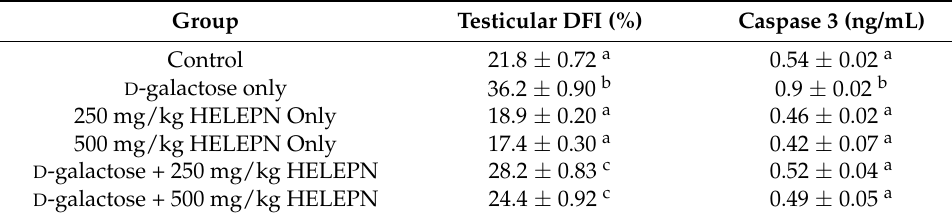
Table 4. Effect of graded doses of HELEPN on apoptotic biomarkers.